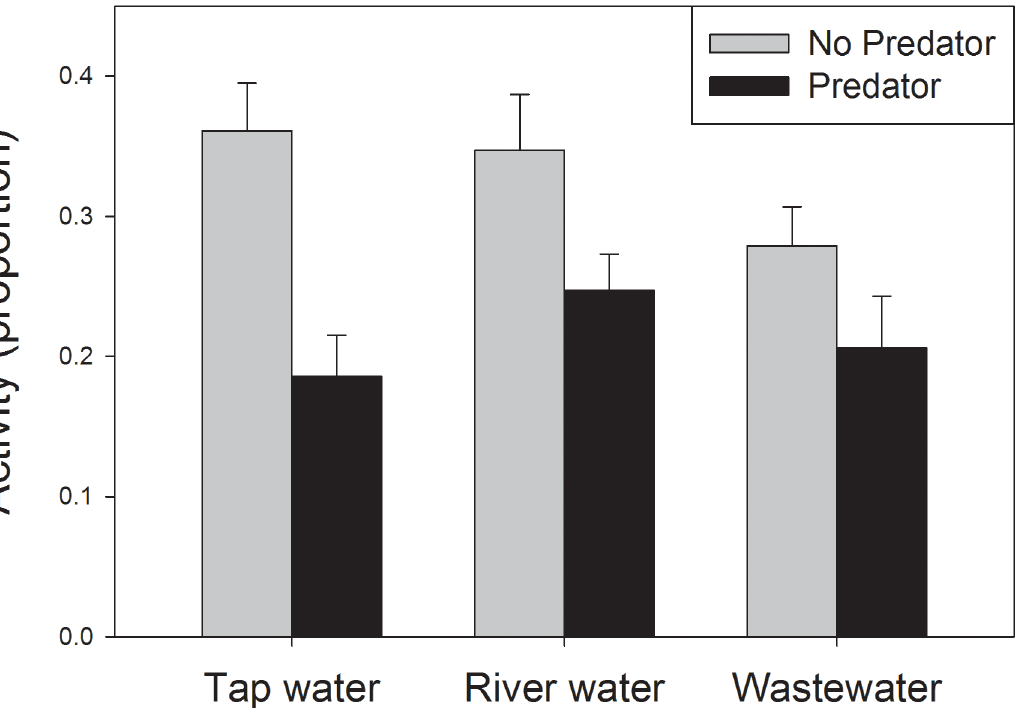
Fig 1. Effect of predator cues on activity of gray treefrog tadpoles. Tadpoles were housed in water drawn from three sources. Activity was scored as mean proportion of individuals that moved during 20-second observation bouts. Response to predator cues depended on water source. Bars represent one standard error, N = 16 replicates per treatment